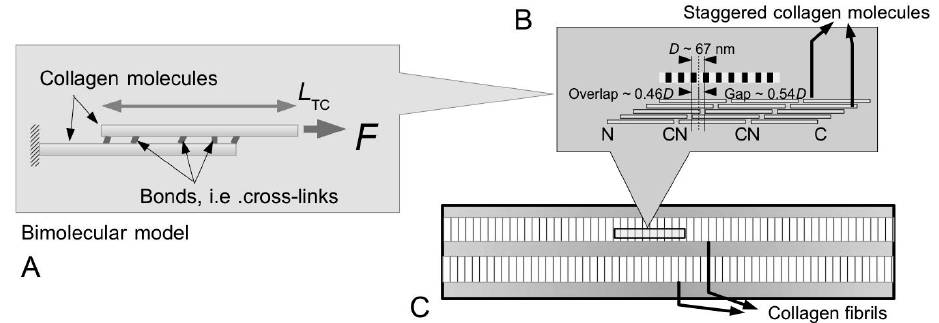
Figure 6. Schematic of collagen molecules in tension in collagen fibrils. ( A ) the Buehler bimolecular model [110], i.e., two collagen molecules sliding under a tensile force, F . Symbol L TC represents the length of the molecule; ( B ) the axial-staggering of collagen molecules in a fibril. The staggered arrangement gives rise to light-dark bands (i.e., the D-periodic patterns) along the collagen fibril. Symbols D represents the D period of the collagen fibril; N and C denote the amino-terminus (containing an amine group) and C-terminus (containing carboxyl group) of the collagen molecule, respectively; ( C ) Two adjacent collagen fibrils.